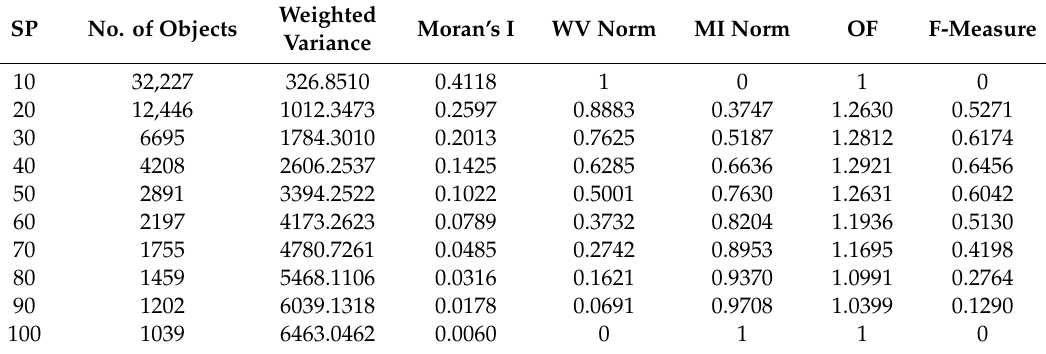
Table 4. Optimum scale parameter values selected for a single scale using the objective function (OF) and the F-measure methods (Equations